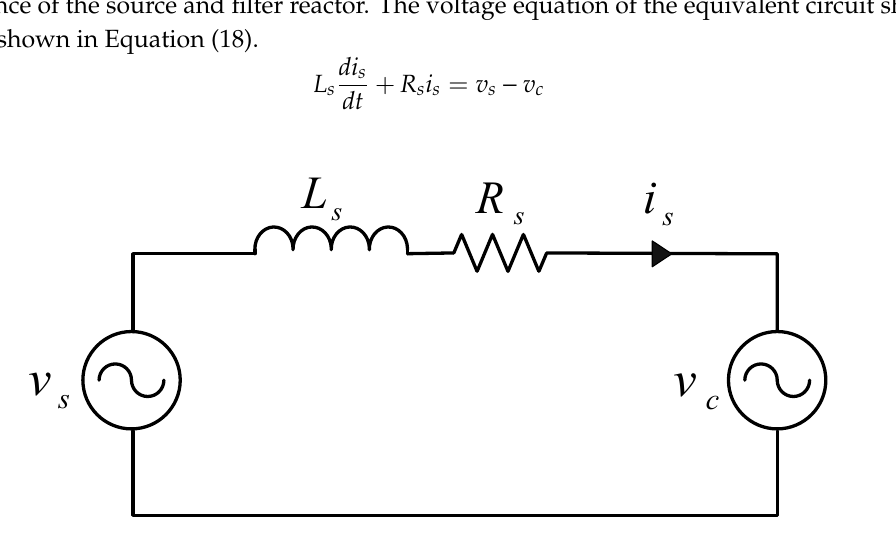
Figure 9. Equivalent circuit of PCS system.